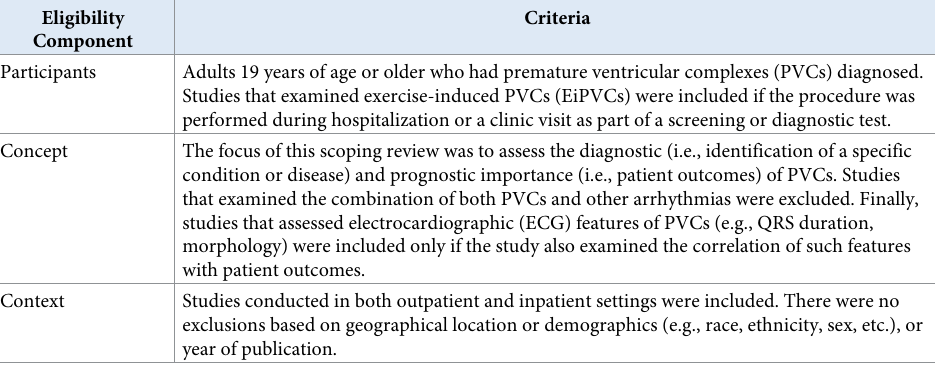
Table 1. Population, Concept, and Context (PCC) eligibility criteria used to identify premature ventricular com- plex (PVC) studies for the scoping review [28], adapted from the Joanna Briggs Institute (JBI)